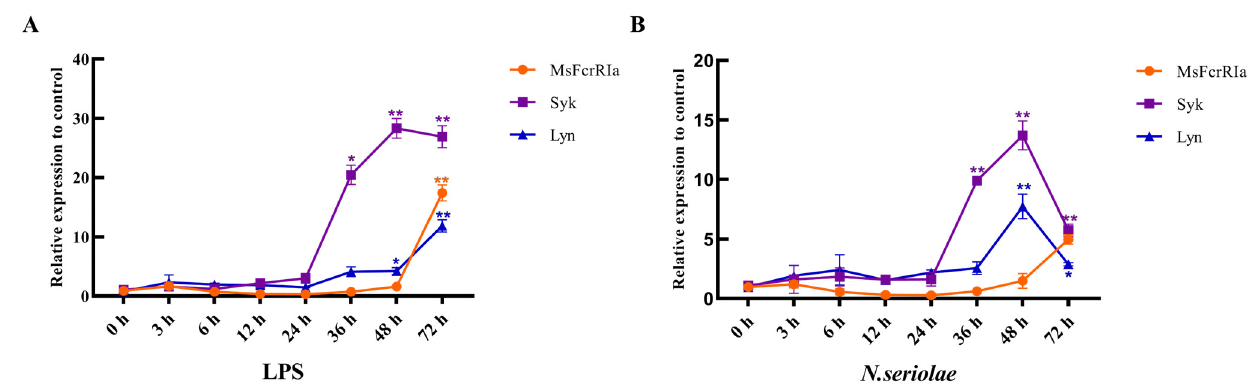
Figure 8. Relative expression analysis of genes in leukocytes with LPS (50 ng/µL) ( A ) or N. seriolae (1 × 10 8 CFU/mL) ( B ) stimulation. Gene expression levels were normalized by β -actin. Data are expressed as the mean ± SD compared with the control group (PBS-stimulated), and asterisks show a significant difference ( * p < 0.05, ** p < 0.01). The data were averaged from three independent experiments with three parallel repeats, n = 3.